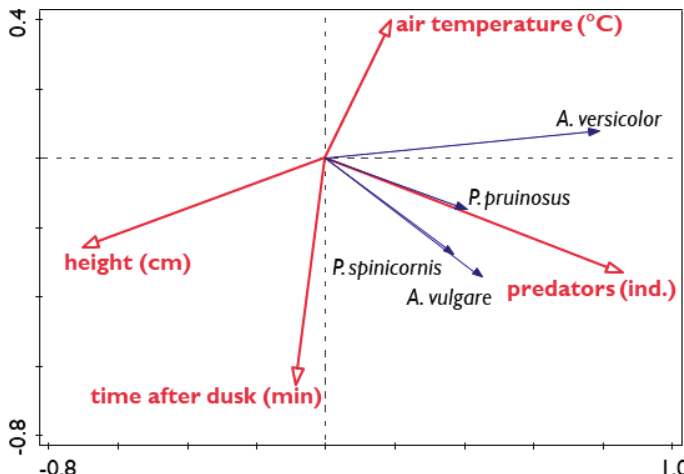
Figure 5. RDA-biplot for the distribution of different species of terrestrial isopods (blue arrows) on the wall during a 90-min observation in October 2019 and environmental variables (red arrows). Only envi- ronmental variables with a significant effect on terrestrial isopod distribution are